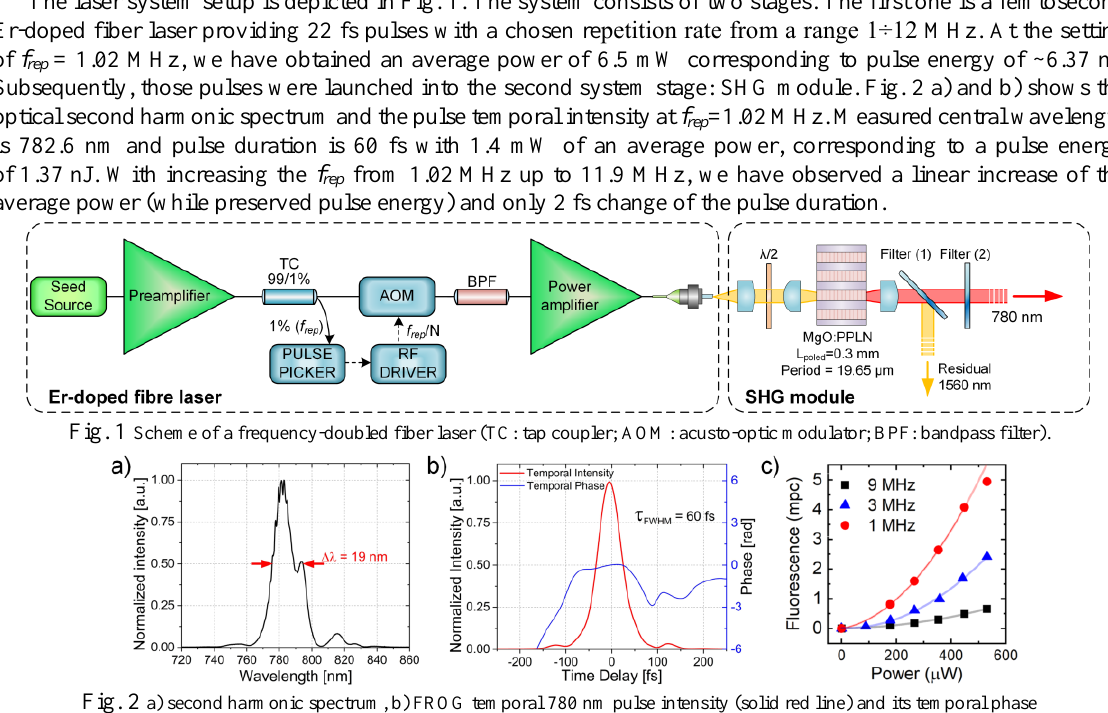
Fig. 2 a) second harmonic spectrum, b) FROG temporal 780 nm pulse intensity (solid red line) and its temporal phase (solid blue line), c) Fluorescence intensity of ex vivo rat skin in mean photon counts per pixel (mpc) as a function of excitation average power for 1, 3, and 9 MHz repetition